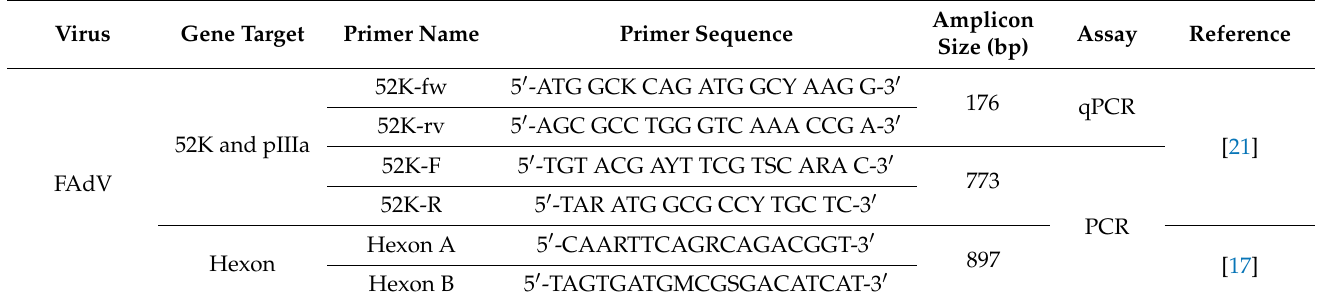
Table 1. Primer sequences, gene targets, and assays used for the amplification and quantification of